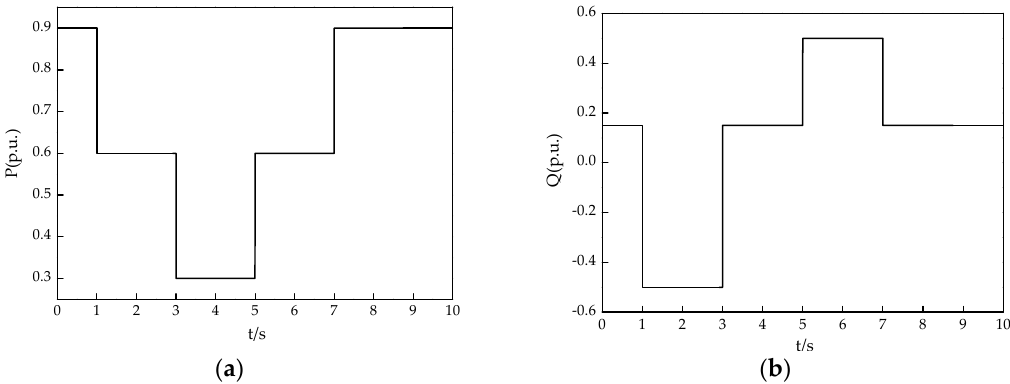
Figure 2. ( a ) Reference value of active power of the converter; ( b ) reference value of reactive power of the converter.